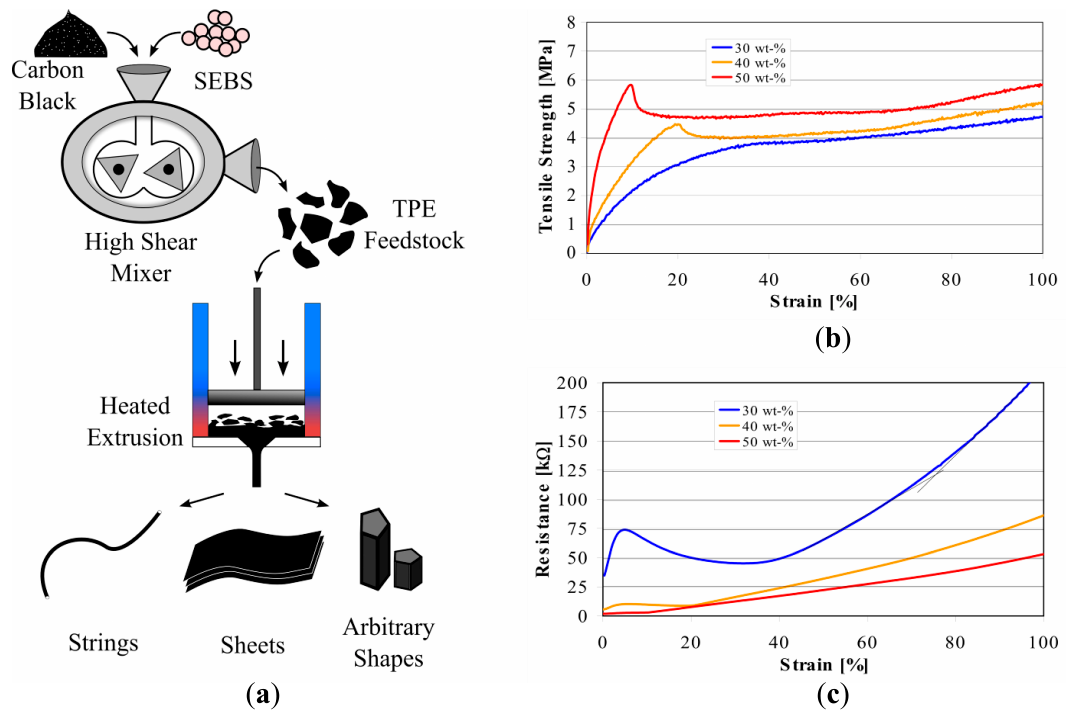
Figure 2. Thermoplastic and mechanical properties of CTPE. ( a ) Fabrication process that can easily generate arbitrary forms; ( b ) Mechanical and ( c ) electrical properties of CTPE when shaped into fibers adapted from previous work by EMPA